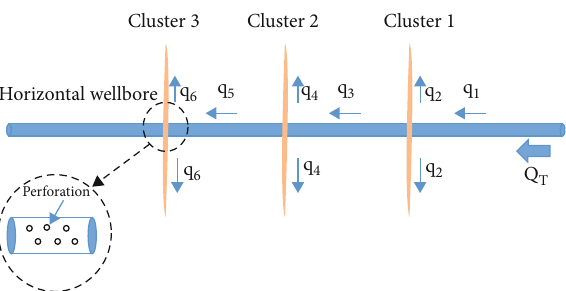
Figure 1: Schematic of multicluster fracturing within a stage.